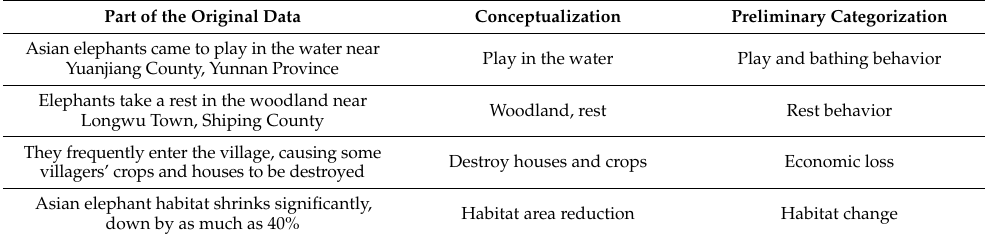
Table 1. Example of open